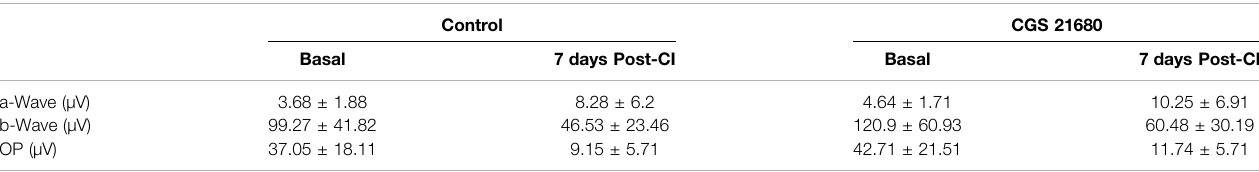
TABLE 2 | ERG recordings of eyes treated with CGS21680 and their controls. Mean values and standard deviations are shown. No statistical differences were found between